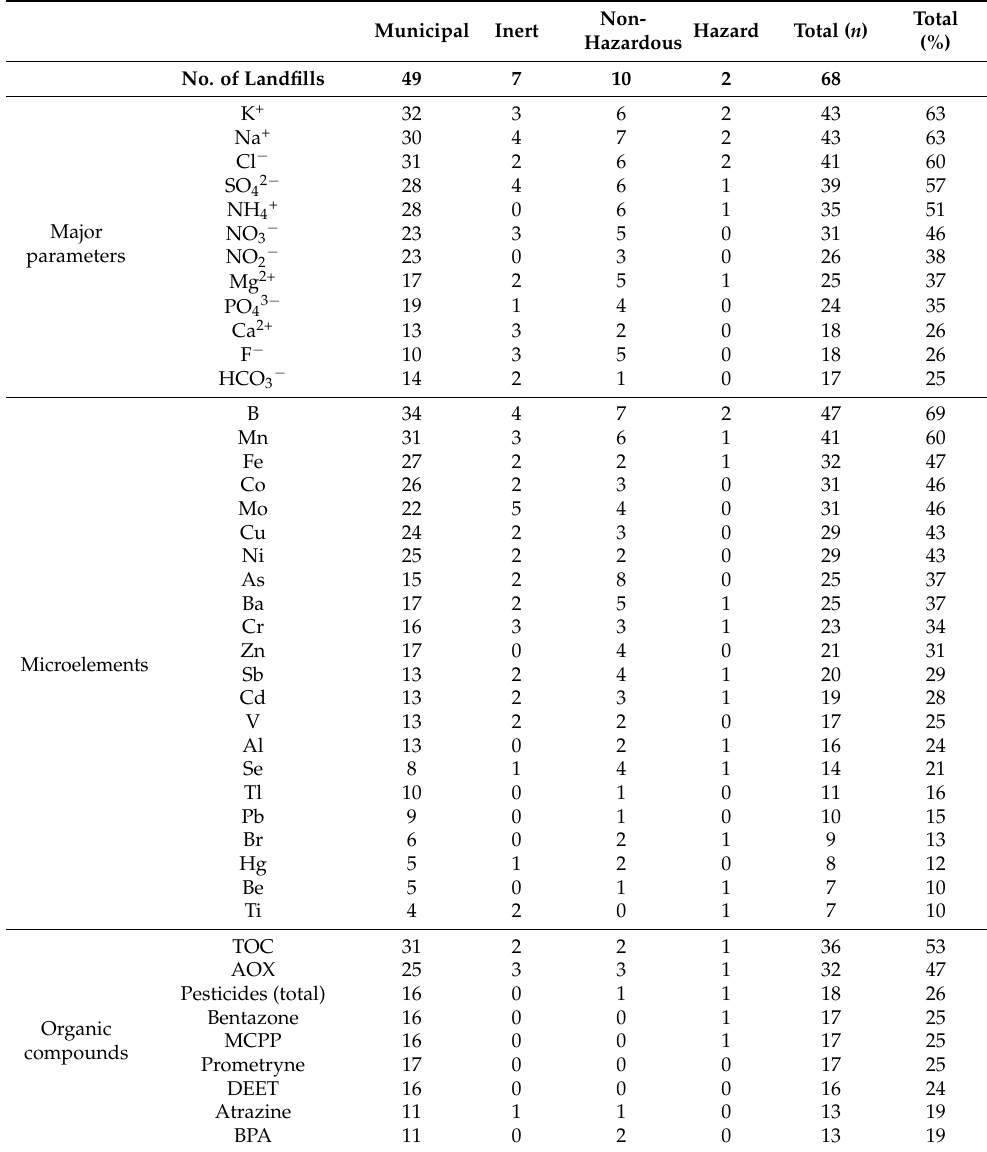
Table 4. Identification of indicative parameters by group of parameters and type of